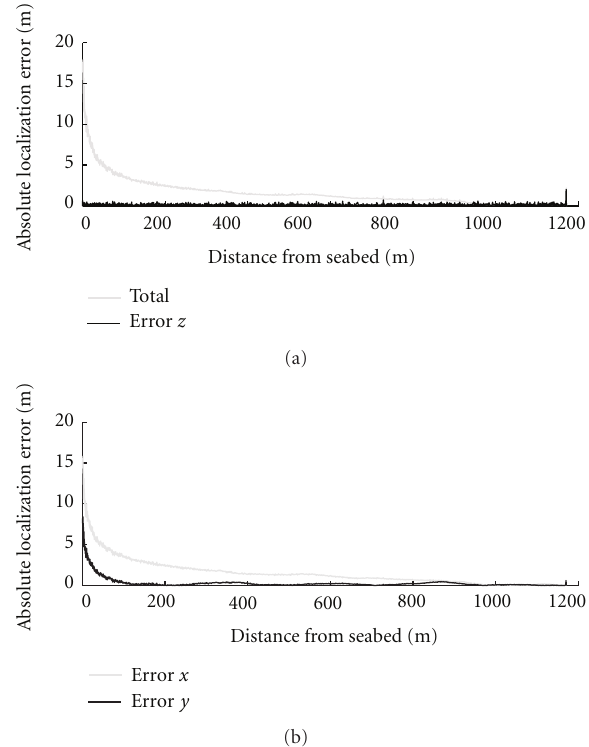
Figure 12: Localization error (in global coordinates) for the static neutral case as a function of the distance from the seabed.